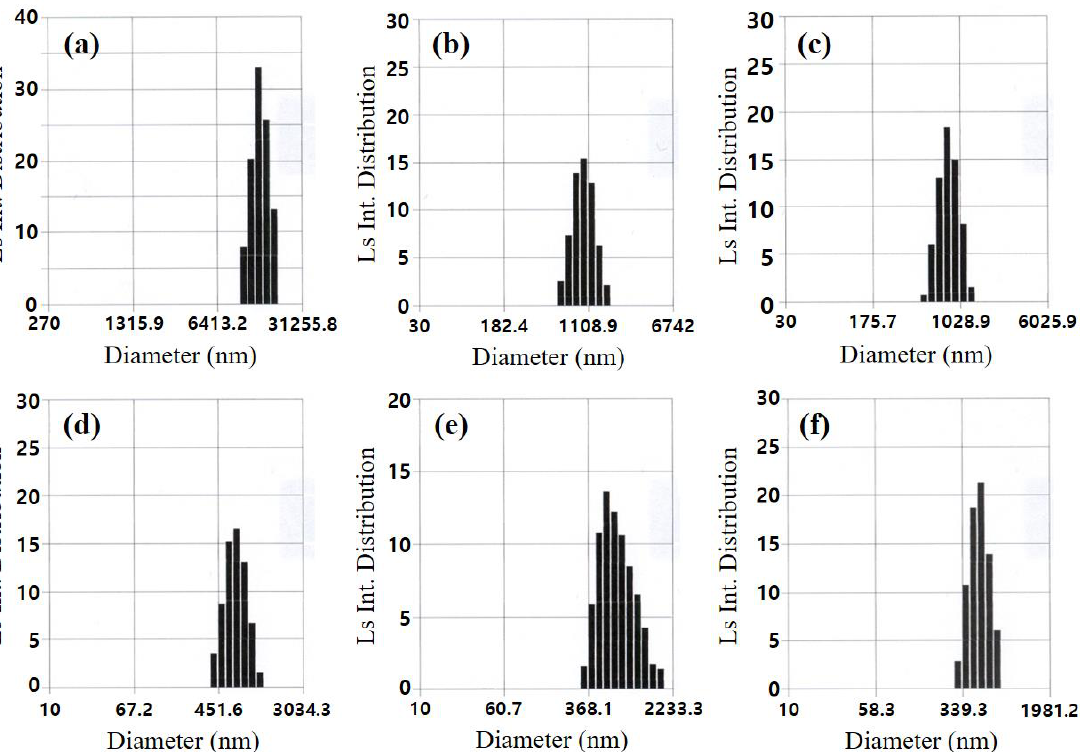
Figure 7. Particle size distribution of KNN particles synthesized by glycothermal treatment with various solvent volume ratios of B/W at 200 °C for 12 h: ( a ) 20/50, ( b ) 30/40, ( c ) 40/30, ( d ) 50/20, ( e ) 60/10, and ( f ) 70/0 (pure glycothermal).